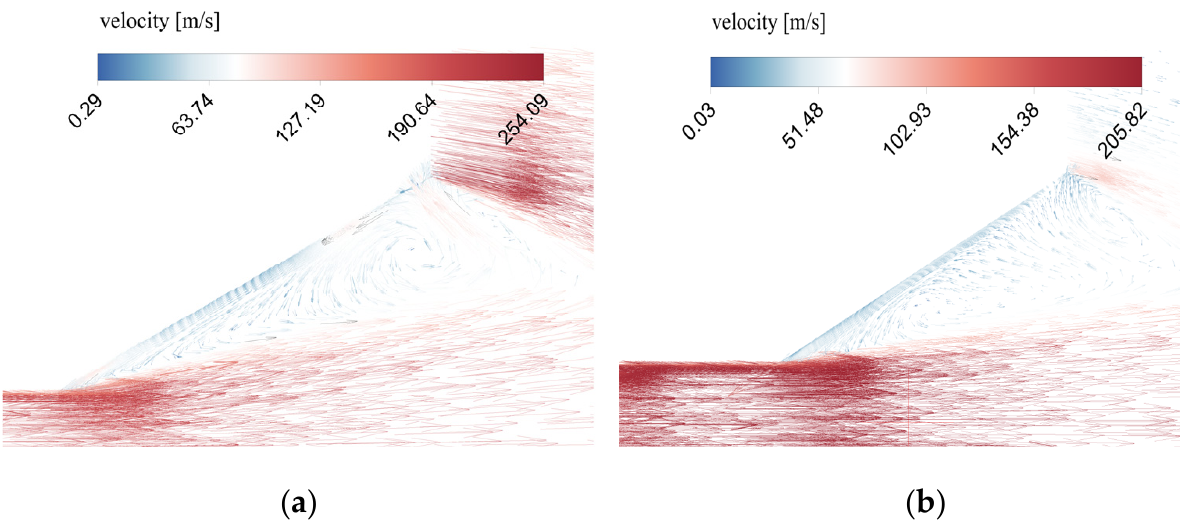
Figure 3. Velocity vector contour on expansion part. ( a ) The standard model; ( b ) the RNG model.